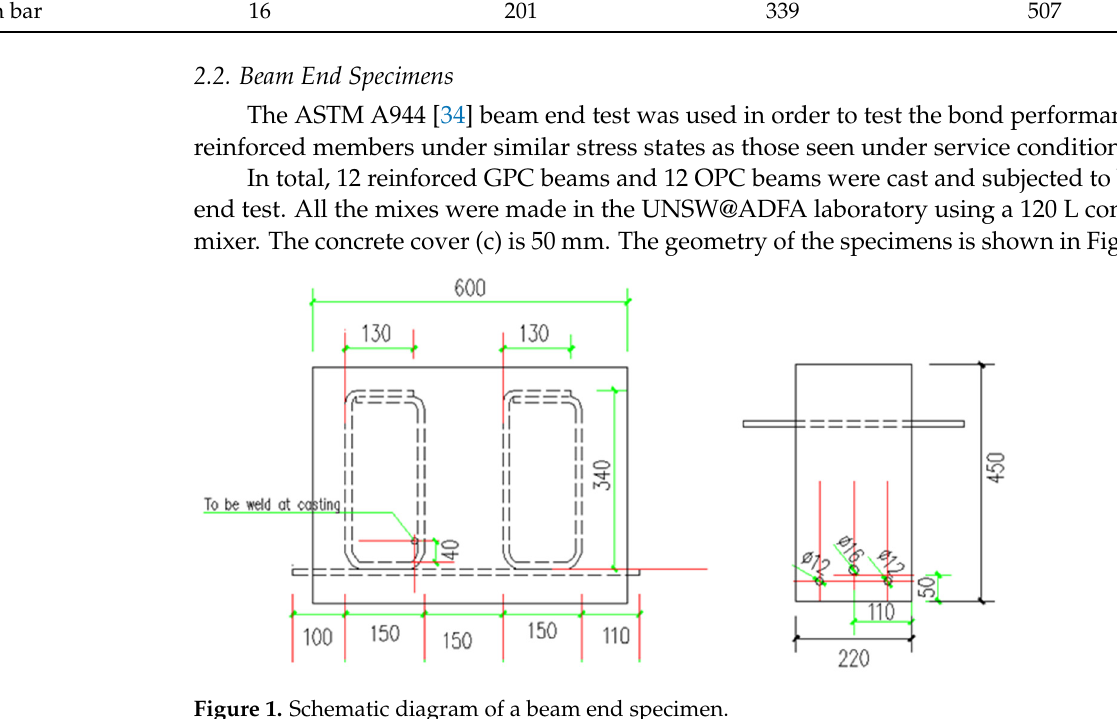
Figure 1. Schematic diagram of a beam end specimen.